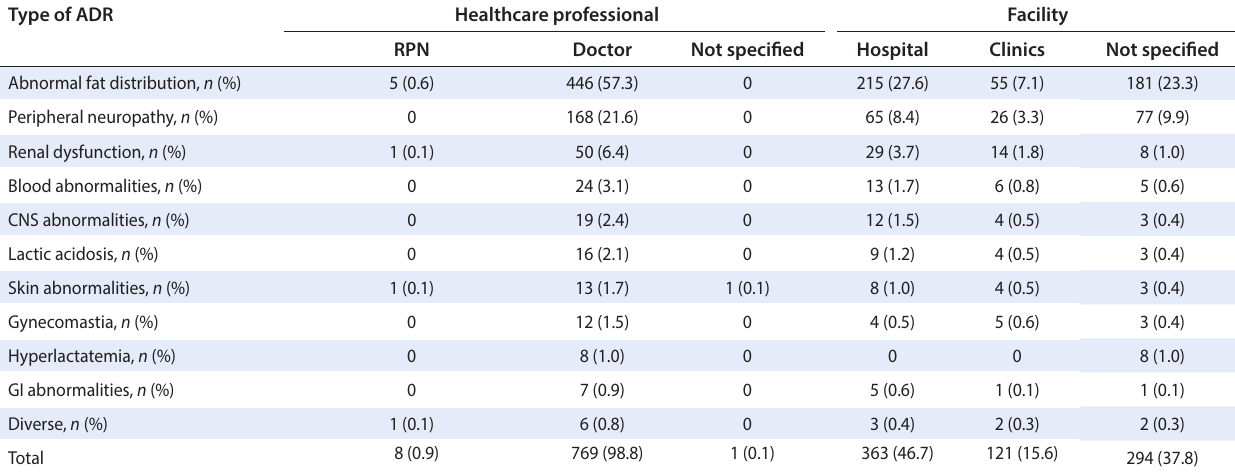
Notes: RPN: registered professional nurse; CNS: central nervous system; GI: gastrointestinal.